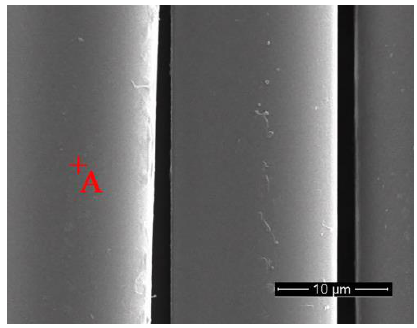
Figure 5. SEM images of desized basalt fibers.